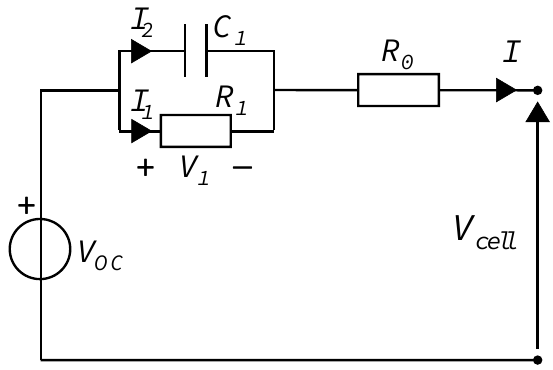
Figure 2. Equivalent electrical circuit for the lithium cell.